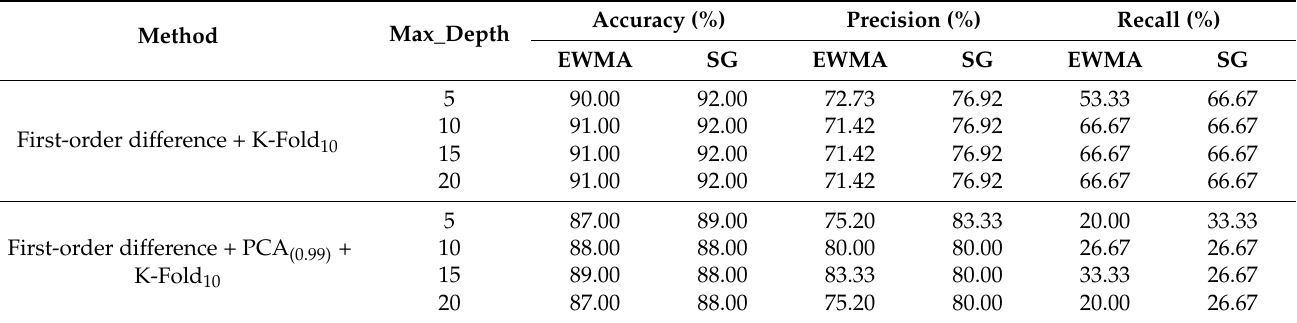
Table 11. Random forest prediction result.